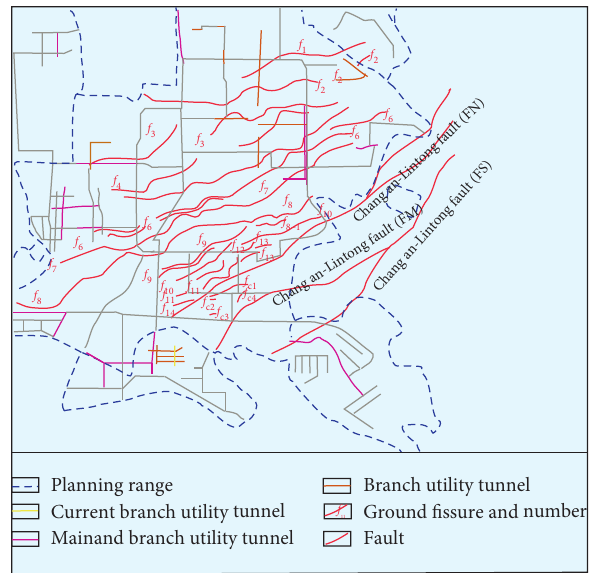
Figure 2: Xi’an underground utility tunnel plaining and ground fissure distribution